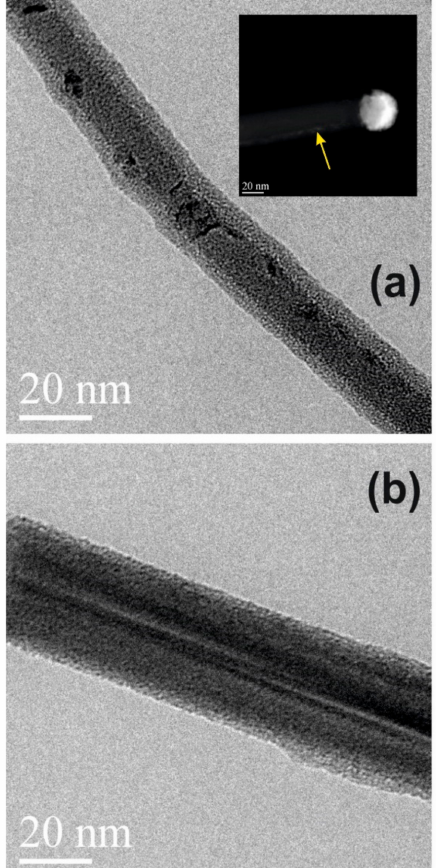
Figure 6. ( a ) TEM micrograph in cross-sectional view of nanowires without any previous gold etching process and annealed by Rapid Thermal Annealing (RTA) at 800 ◦ C for 30 min. The inset shows a STEM image of the same sample. It is clearly visible that Au is present not only on the tip, but also on the NW sidewalls (as indicated by the yellow arrow). ( b ) TEM micrograph in cross-sectional view of Si-NWs with the double-step gold etching process and annealed by RTA at 800 ◦ C for 30